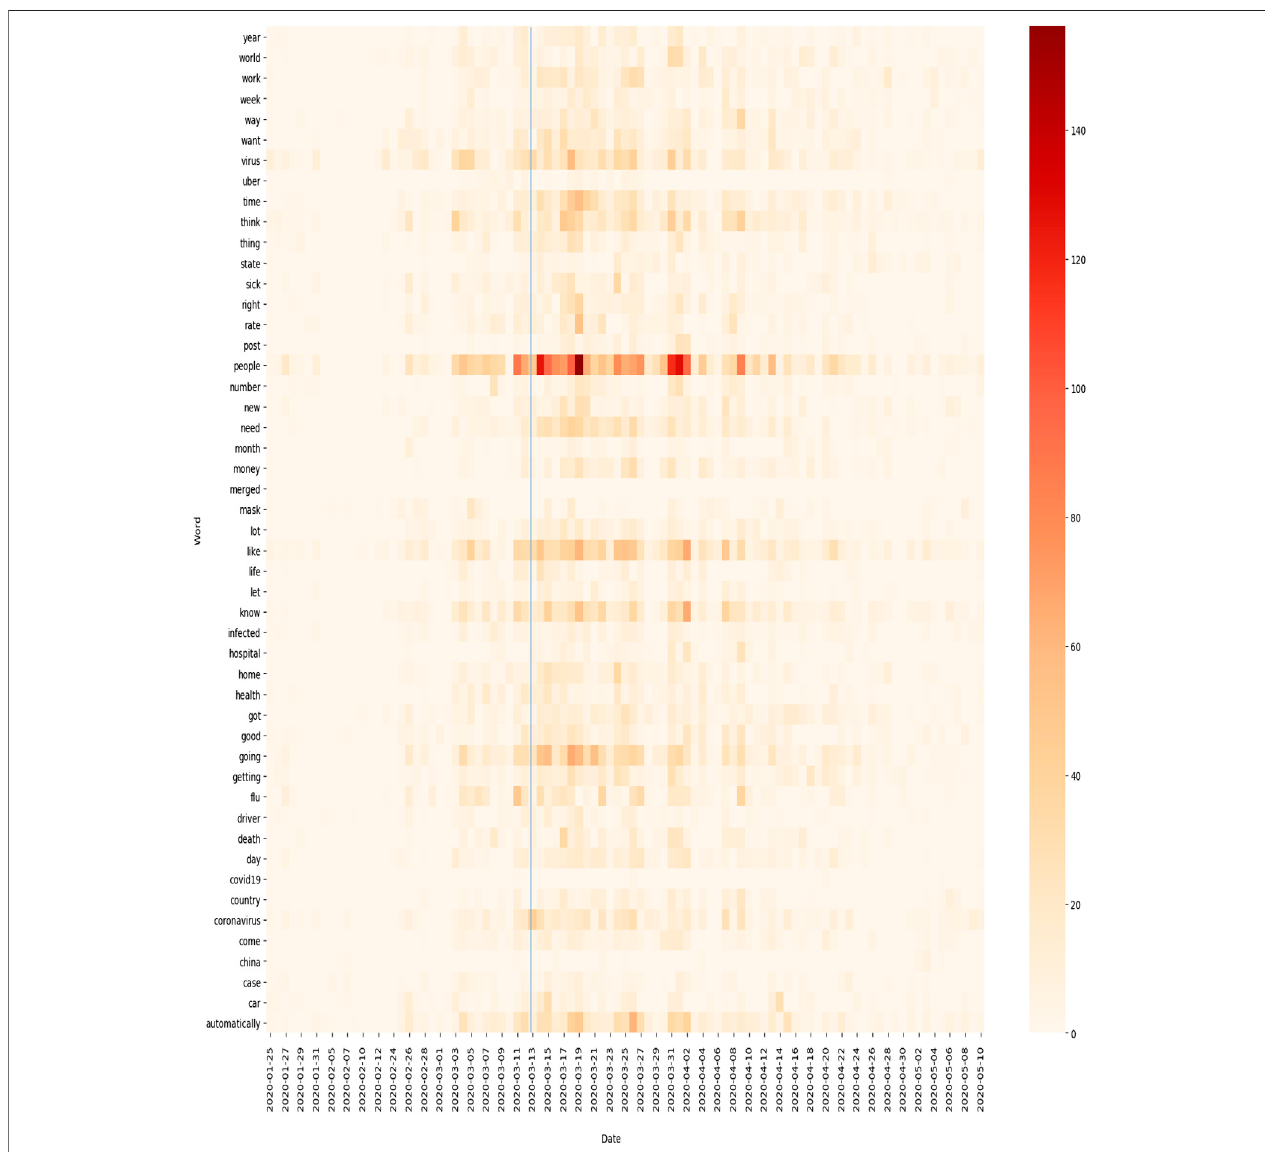
FIGURE 1 | Heatmap of Corona